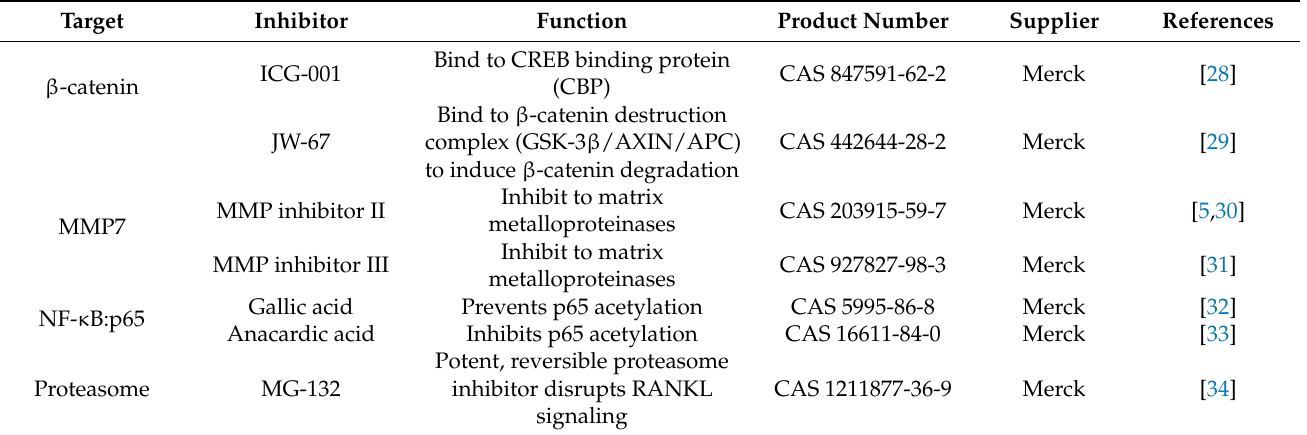
Table 2. Inhibitors used in this